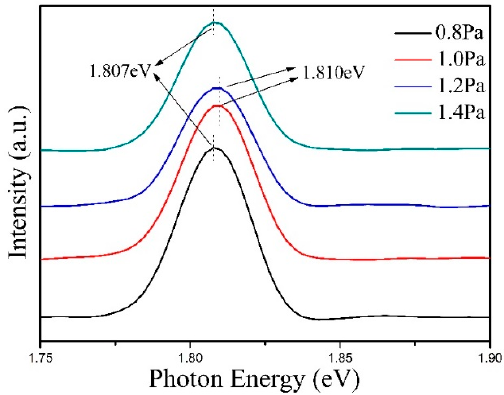
Figure 4. Photoluminescence spectra of the MoS 2 films deposited at different pressures.